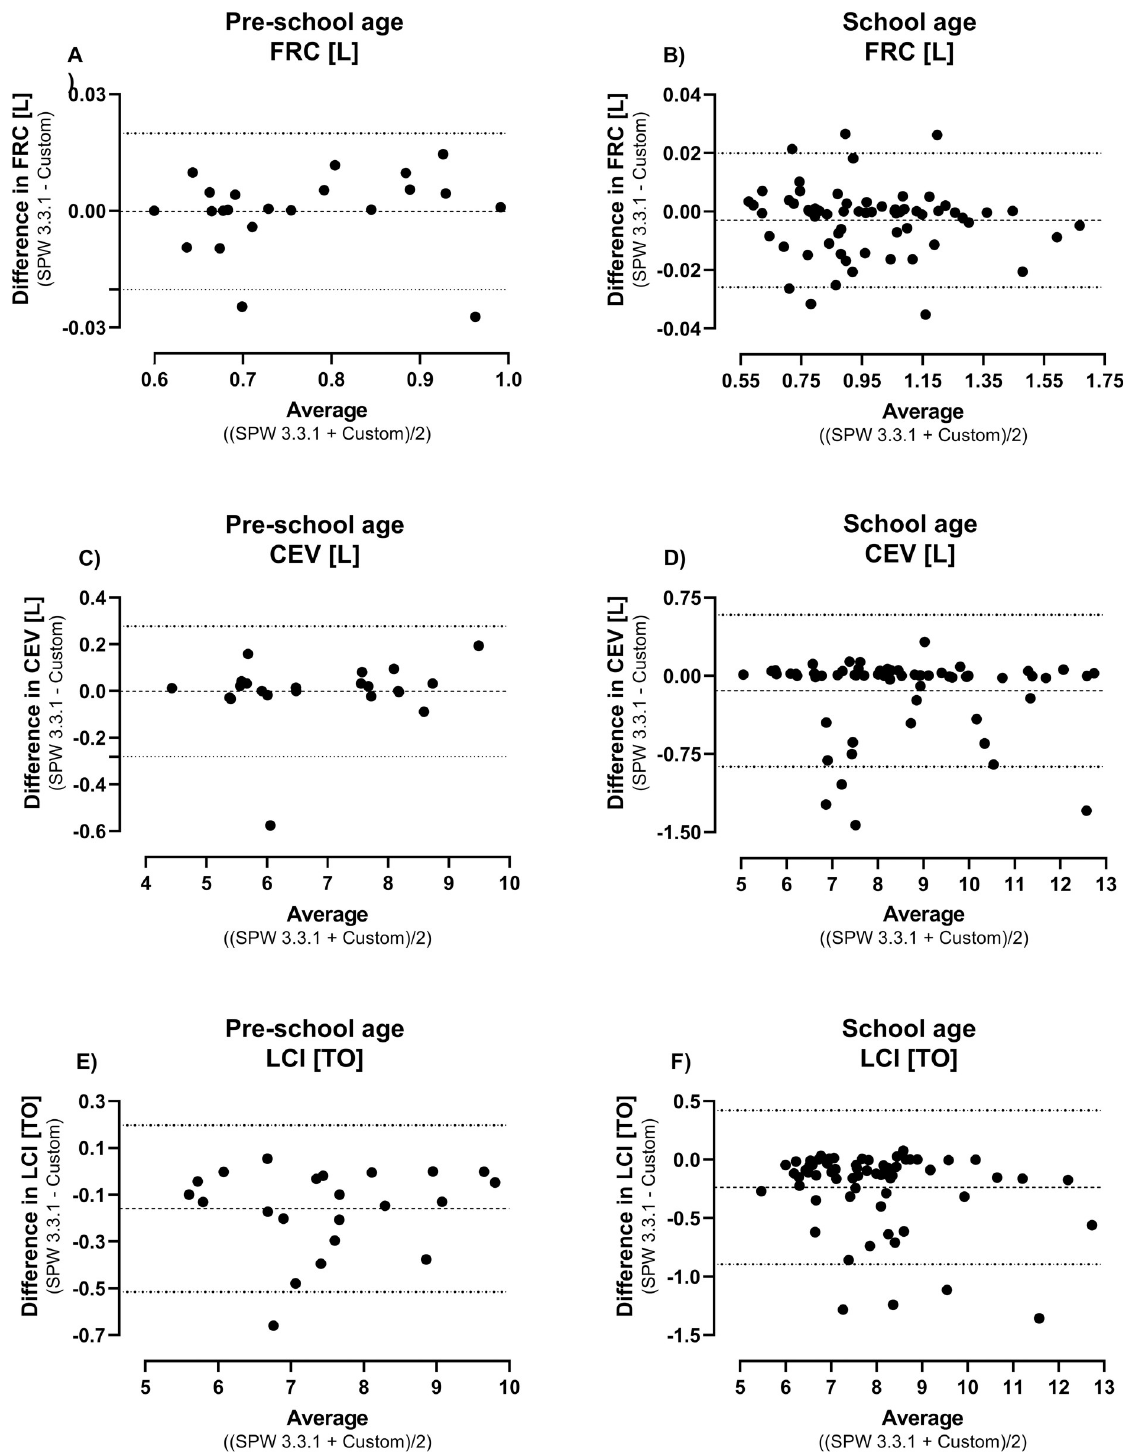
Fig 3. Bland-Altman plots of absolute difference between the commercial and custom breath detection algorithm. Shown are absolute differences in main MBW outcomes (FRC, CEV, LCI) for pre-school and school-age subjects with a difference in total breaths detected > 10%. Abbreviations: FRC: functional residual capacity; CEV: cumulative expired volume; LCI: lung clearance index.